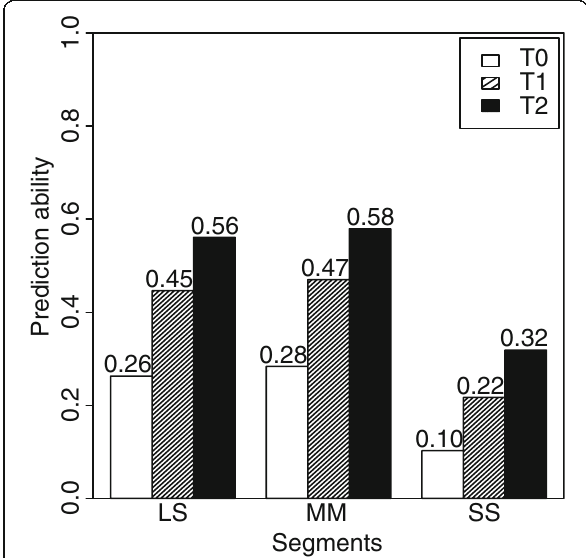
Fig. 3 Prediction ability of grain yield performance for different subgroups of market segments LS, MM, and